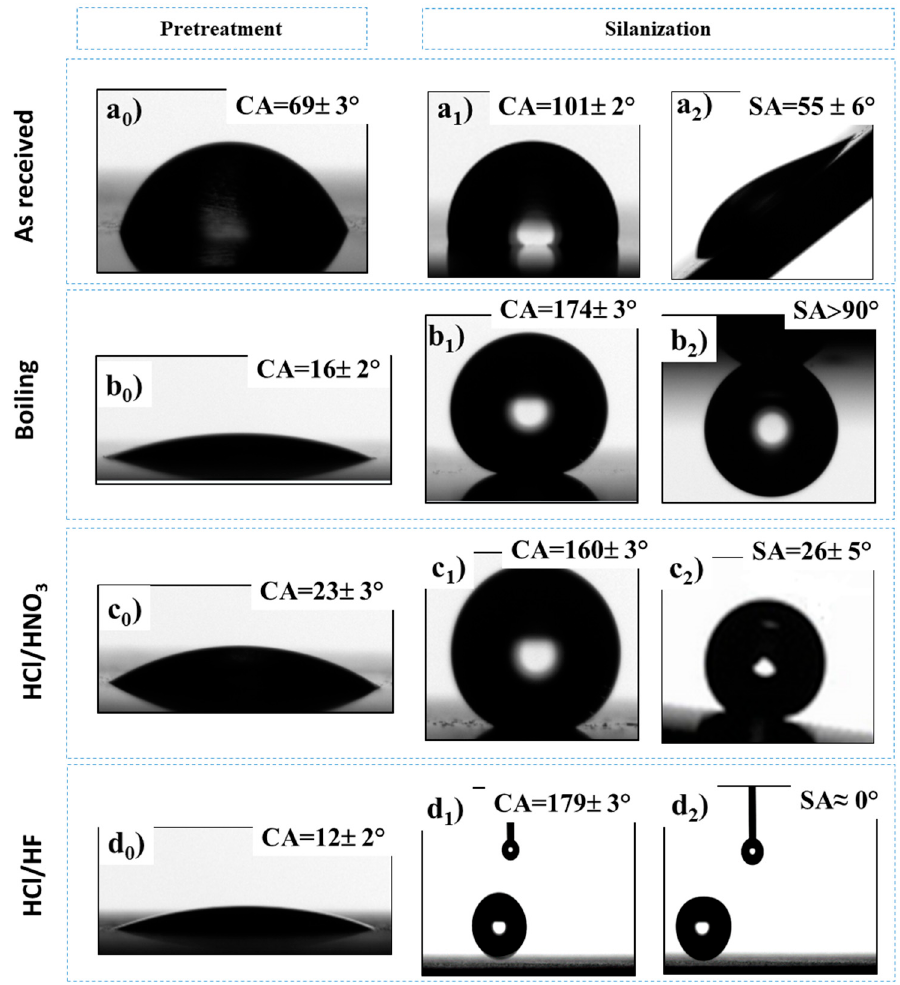
Figure 5. Images of water contact angles (CAs) and sliding angles (SAs) with average values and errors on Al alloys surface: ( a i ) A_R; ( b i ) A_W; ( c i ) A_N; ( d i ) A_F where a 0 is the just-cleaned sample, b 0 is the boiled sample, and c 0 and d 0 are the etched samples.